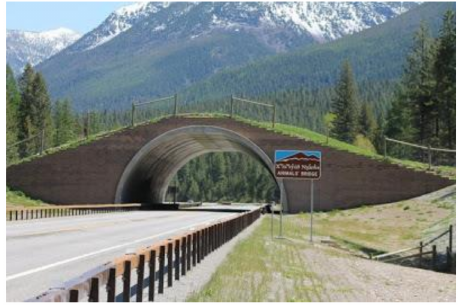
Figure 1. An example of an overpass in Montana, USA.